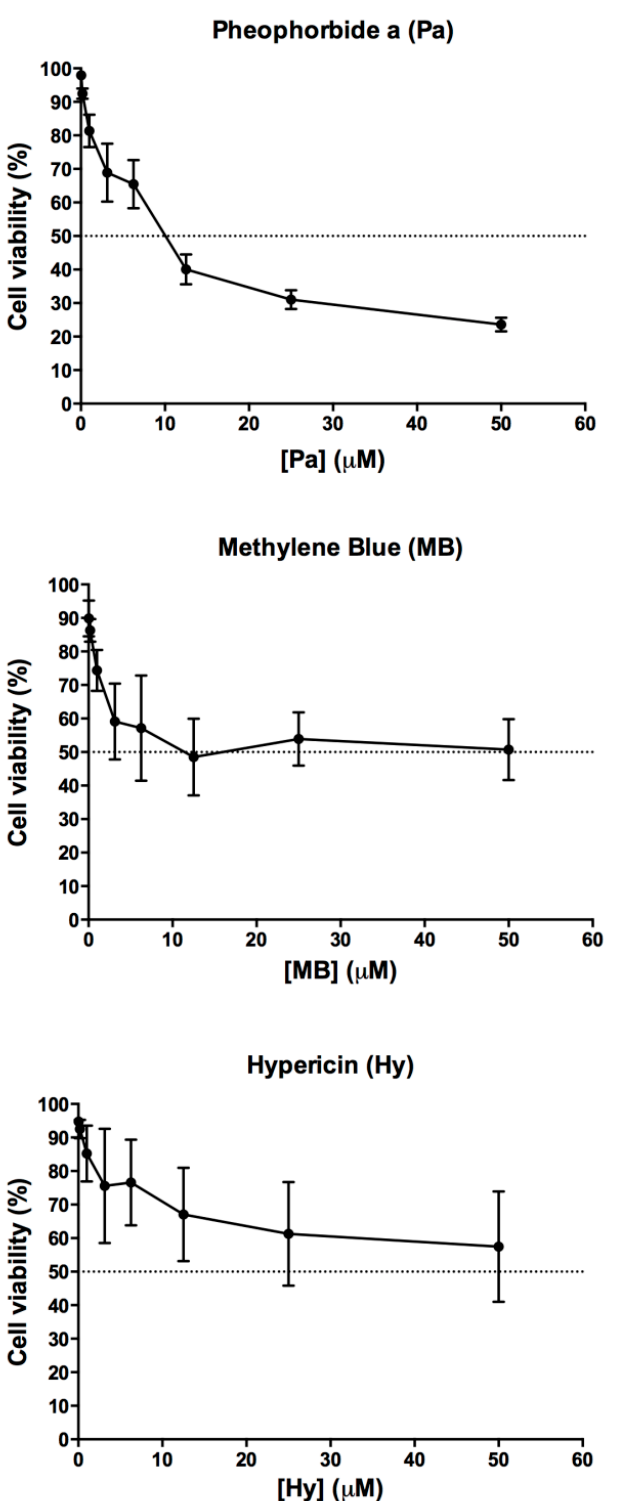
Figure 11. Cytotoxicity of Pa, MB and Hy, without light irradiation on human neutrophils isolated from buffy coat. Data are mean ± SEM ( n = 3).